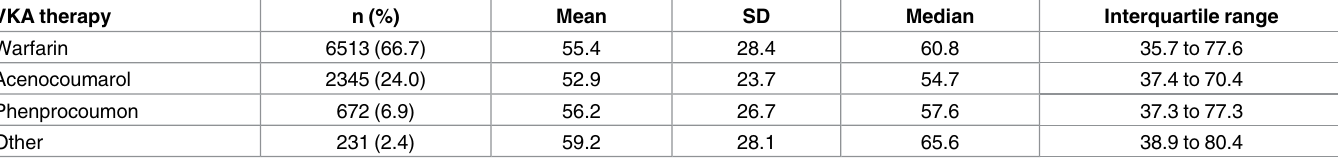
* N = 9934; data missing for 173 patients. SD, standard deviation; VKA, vitamin K antagonist.